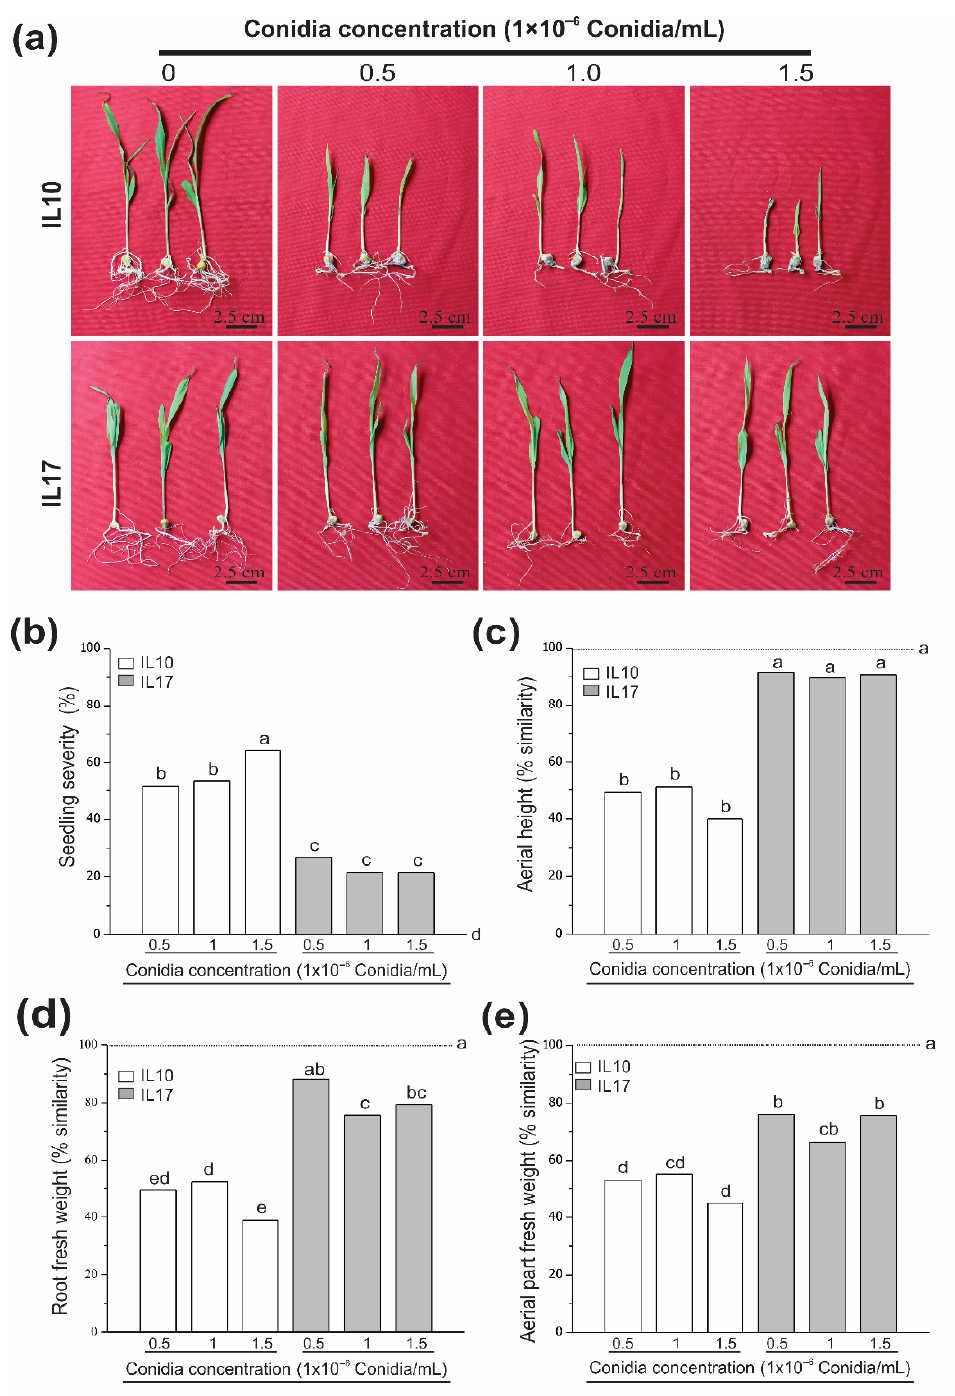
Figure 2. Fusarium e ff ect on maize seedlings at the second leaf collar (V2 stage). ( a ) Seedling phenotypes subjected to the rolled paper assay. The evaluations for ( b ) seedling infection severity, ( c ) aerial height, ( d ) root fresh weight, and ( e ) aerial part fresh weight were recorded 14 days post-inoculation. Similarities in recorded data were determined for each treatment according to its control. The di ff erent letters above the bars refer to significant di ff erences using the Duncan mean test ( α = 0.01; n = 15). The dashed line at 100% represents the control value. The experiments were performed three times with a completely randomized